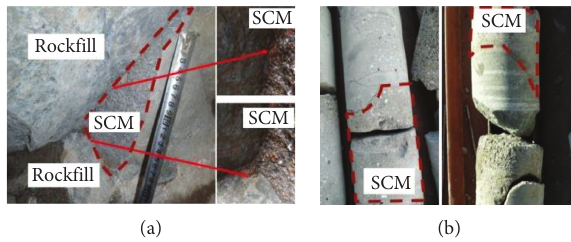
Figure 6: On-site pit inspection and core drilling inspection. (a) On-site pit inspection. (b) On-site core drilling inspection.